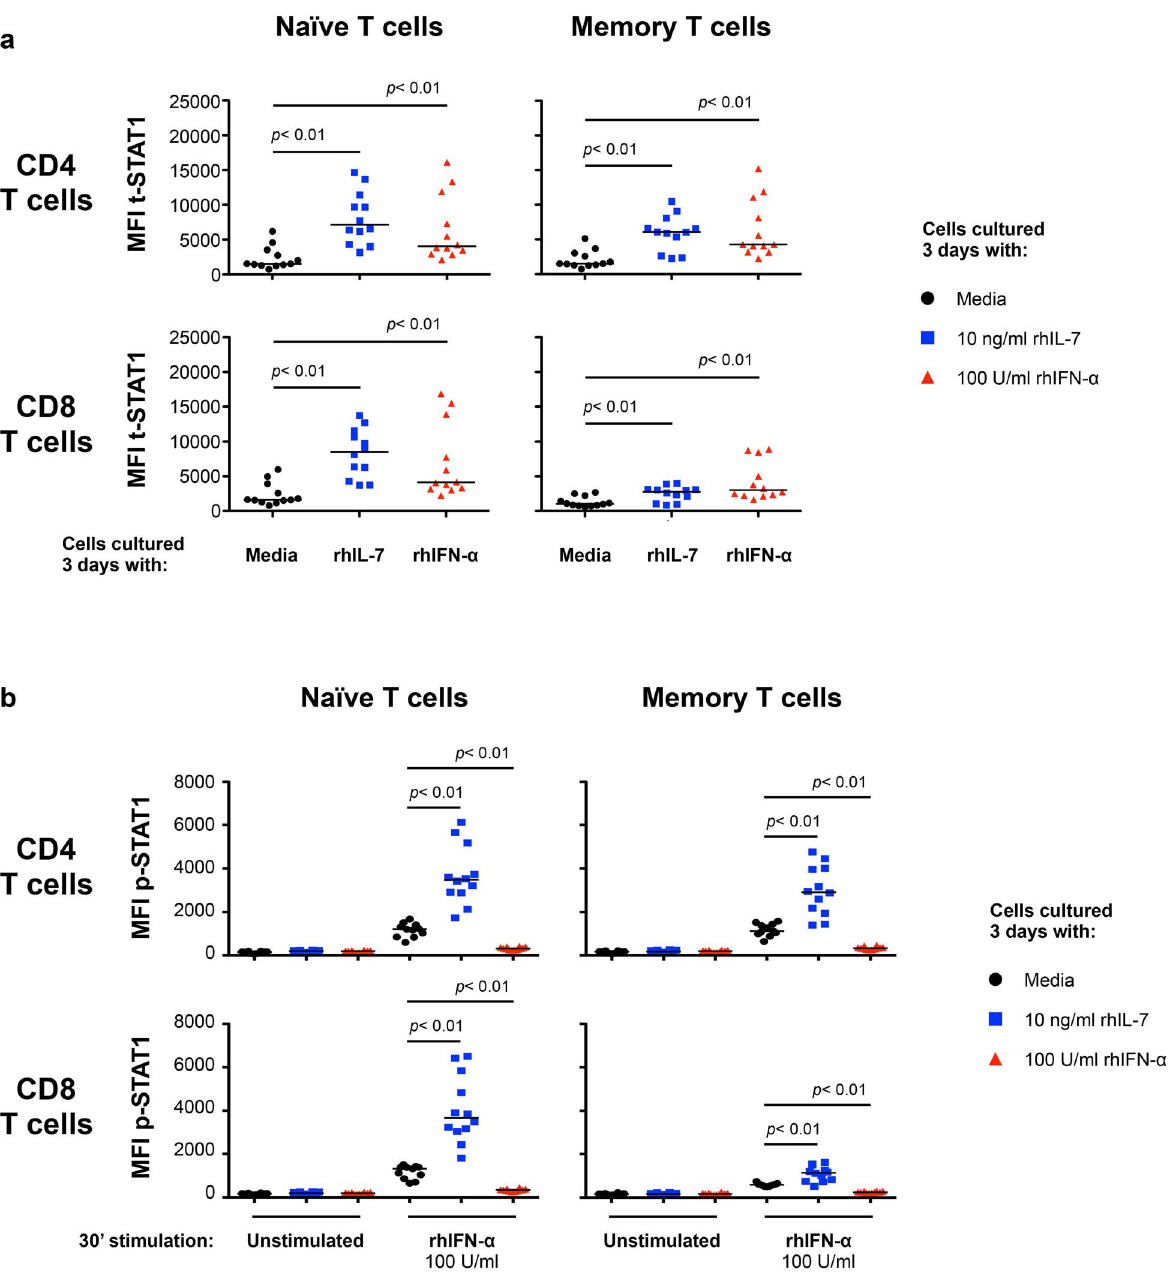
Figure 2. Invitro culture with IL-7 increases IFN- a -induced STAT1 activation (p-STAT1). PBMCs from healthy donors (n=12) were cultured 3 days in media alone (black symbols), rhIL-7 (10 ng/ml; blue symbols) or rhIFN- a (100 U/ml; red symbols). After 3 days of culture, the cells were harvested, washed and rested overnight. Rested cells were stimulated in vitro with rhIFN- a (100 U/ml) for 30 minutes and analyzed for intracellular expression of t-STAT1 ( a ) and phosphorylated STAT1 ( b ) in naı¨ve and memory T cell subsets. A Wilcoxon signed-rank test was performed for comparisons of the MFI of t-STAT1 and p-STAT1 between groups.